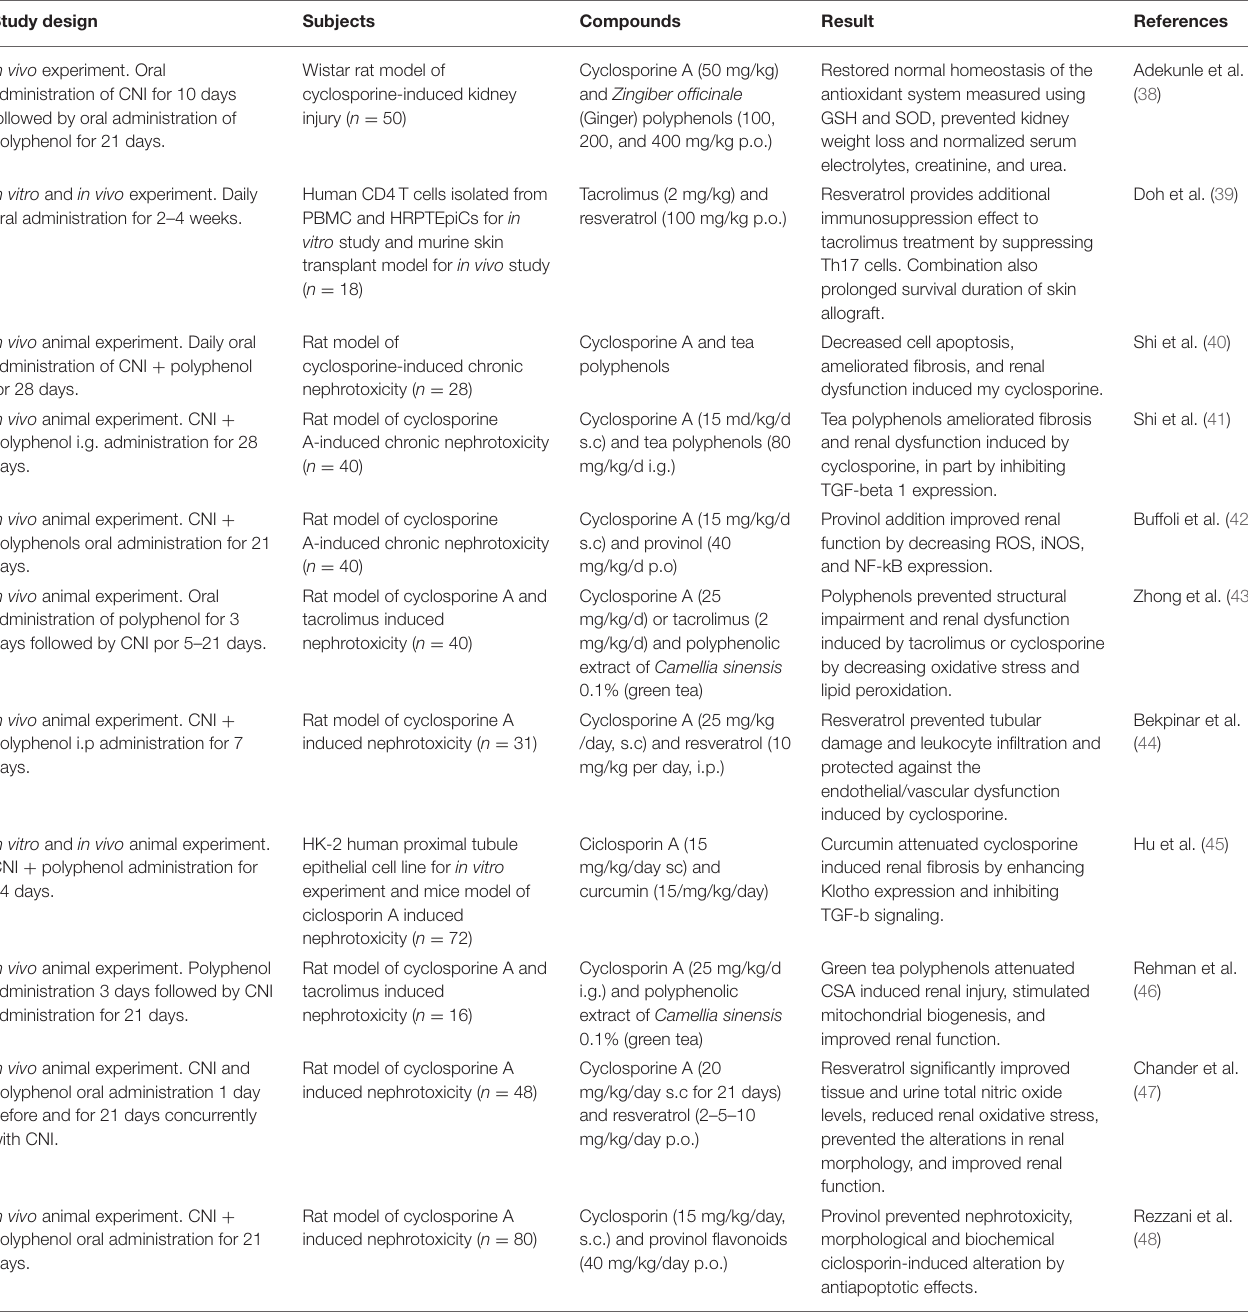
TABLE 2 | Overview of the studies on the effect of polyphenol in prevention of calcineurin inhibitors induced